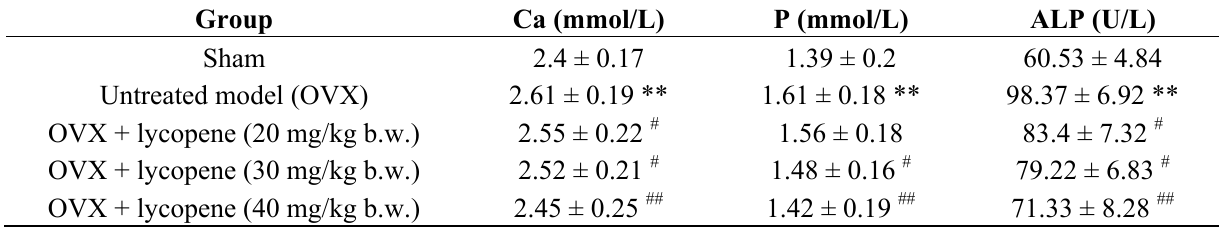
Table 2. Effect of lycopene on serum Ca, P and ALP in experimental rats. Group Ca (mmol/L) P (mmol/L) ALP (U/L) Sham Untreated model (OVX)